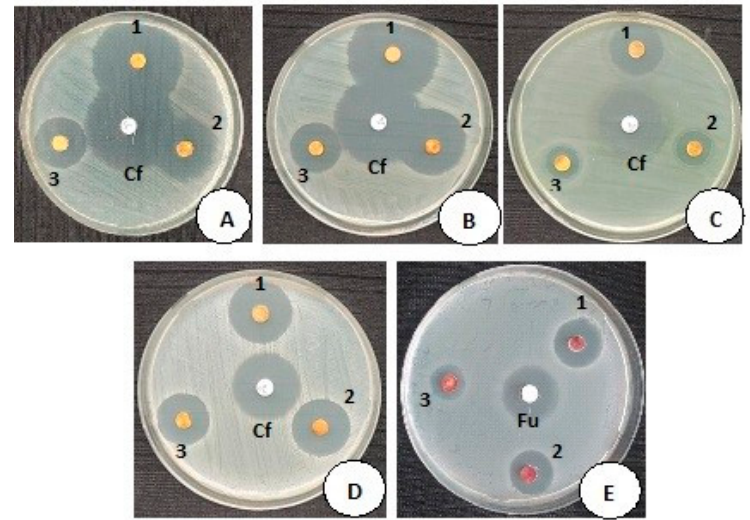
Figure 4. Antimicrobial activity of MgO-Chitosan-Pluronic F127-Escin NPs, activity against ( A ). Escherichia coli (ATCC: 25922); ( B ). Enterobacter cloacae (Clinical isolate); ( C ) . Pseudomonas aeruginosa (ATCC: 27853); ( D ) . Staphylococcus aureus (ATCC: 25923) and yeast fungi, ( E ). Candida albicans (ATCC: 10231). The MgO-Chitosan-Pluronic F127-Escin NPs concentration from 1–3 is successively diluted from 2 mg/mL; 1.5 mg/mL, and 1 mg/mL, respectively. (Cf and Fu are control antibiotic discs Ciprofloxacin Cf: 5 µg; and Fluconazole Fu: 25 µg). Table 1. Quality control study of standard antibiotic discs by disc and antimicrobial activity of MgO-Chitosan-Pluronic F127-Escin NPs .